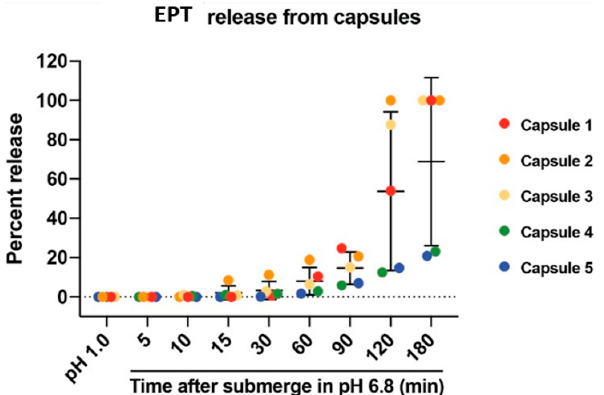
Figure 2. EPT released from enteric-coated capsules is pH-dependent. Release of EPT was measured by CTB sandwich ELISA. EPT releases from capsules only after submersion at pH 6.8. Percent of EPT release from capsules after 2 h submersion in 0.1 N HCl, and at t = 5, 10, 15, 30, 60, 90, 120, and 180 min after pH shift to 6.8. n = 5. Percent release was determined by extrapolation of calculated EPT concentrations using CTB sandwich ELISA compared to a known fixed mass of 5 µg EPT per capsule.